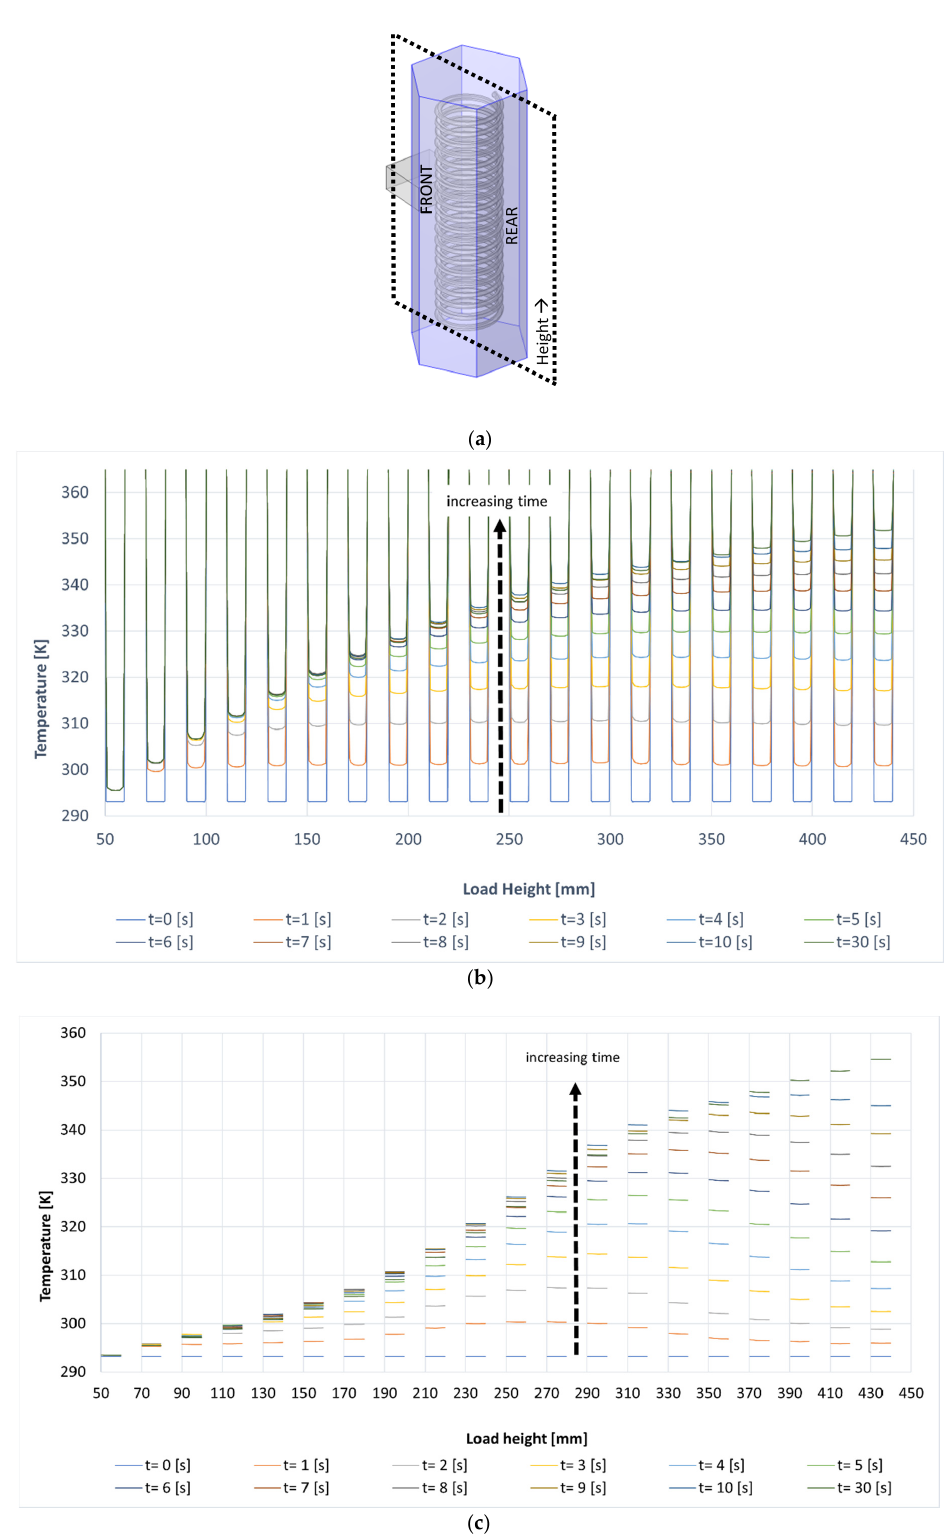
Figure 4. ( a ) Position of the cross section used to extract the data and temperature distribution in the load section along the height of the helix in transient conditions: ( b ) conventional heating and ( c ) microwave heating. Dotted arrows indicate the direction of increasing simulated heating time, from 0 to 30 s. The temperature plots of Figure 4 indicate, for each position on the x-axis, how the temperature increases with time in the cross section of the PTFE pipe where the load is contained. For a given 15 mm interval on the x-axis, corresponding to one helix turn, and time, it is possible to visualize the temperature distribution existing in such a section of the load.